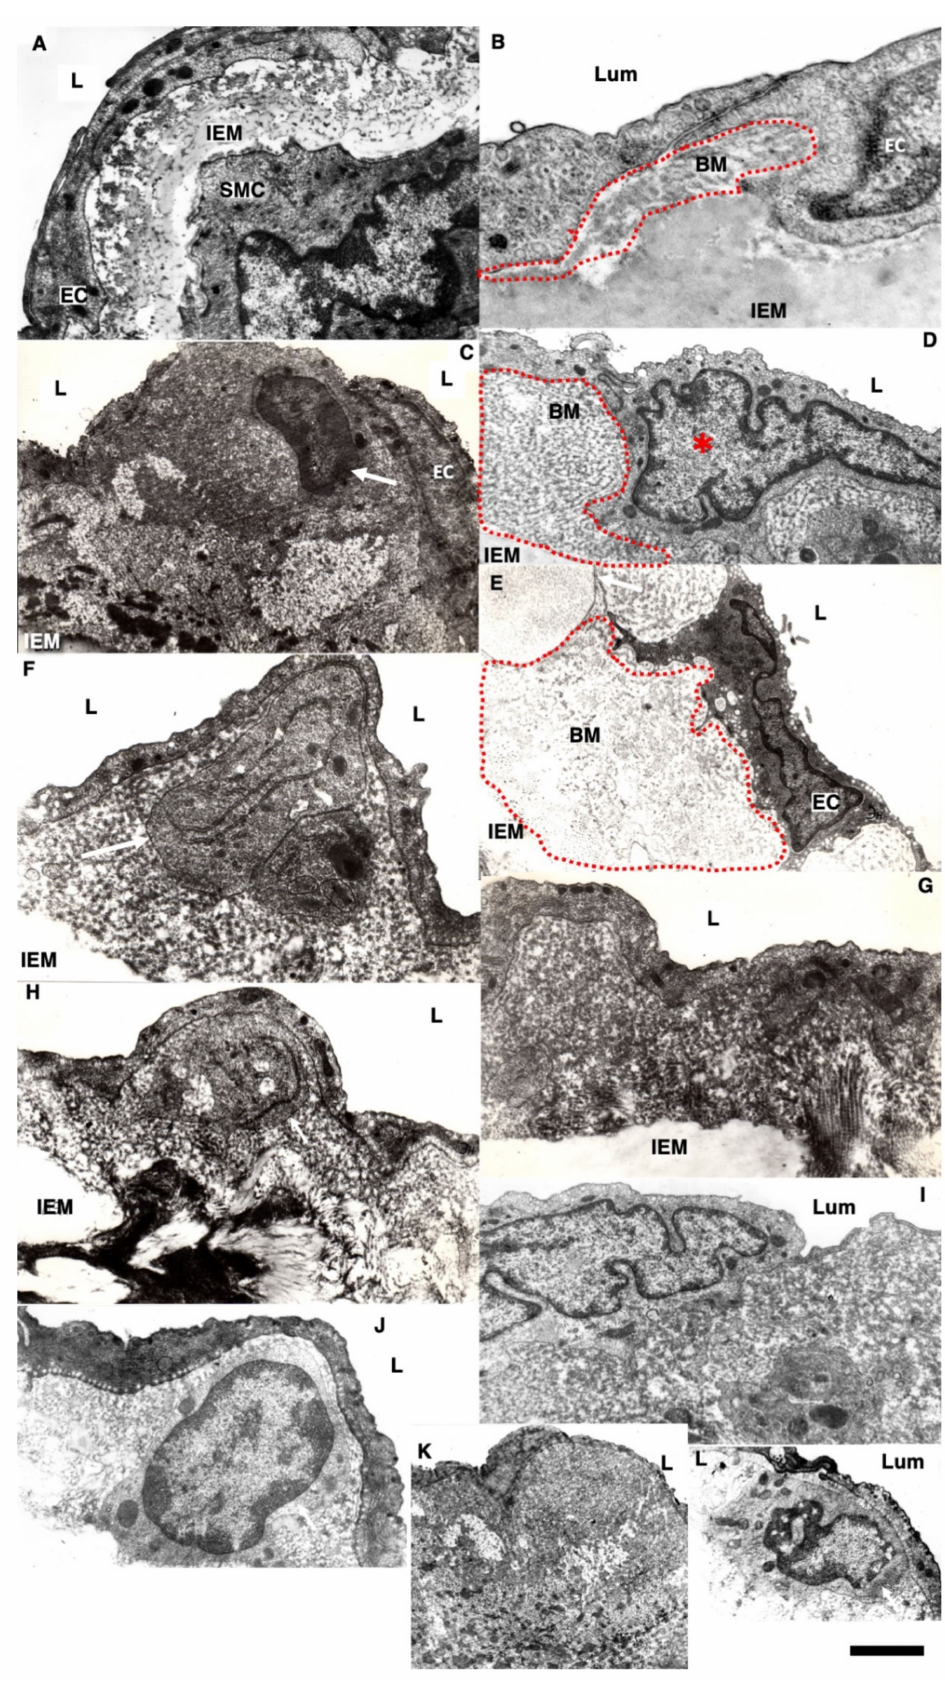
Figure 8. Thickness of the BM of ECs under different conditions. ( A ) Control without